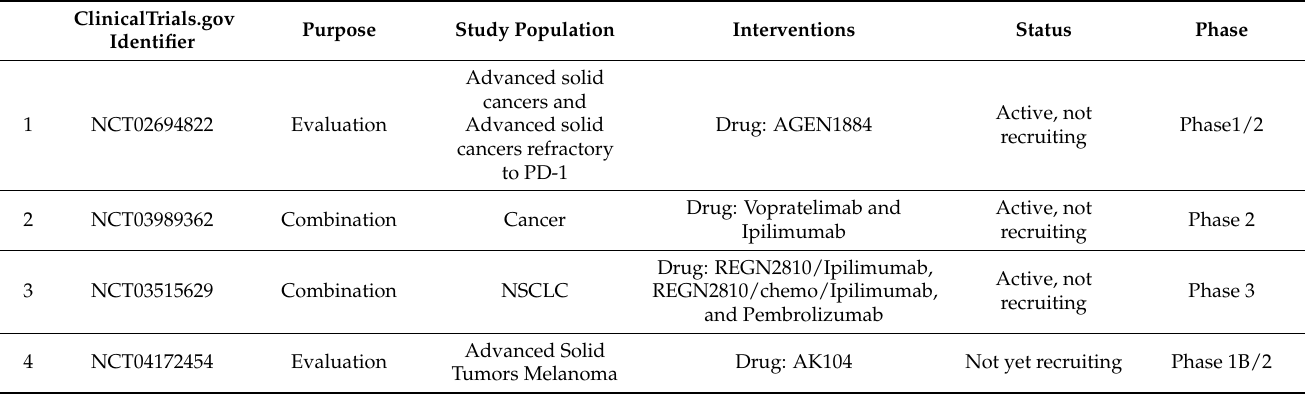
Table 2. Potential immune checkpoint inhibitors under clinical trials enrolled in ClinicalTrials.gov. The search conditions were as follows: status, recruiting and not yet recruiting studies; condition of disease, cancer; other terms, PD-1 or PD-L1 or CTLA-4 or